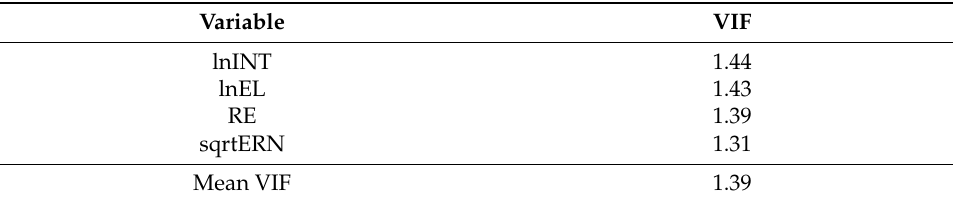
Table 5. Identification of multicollenarity using the VIF